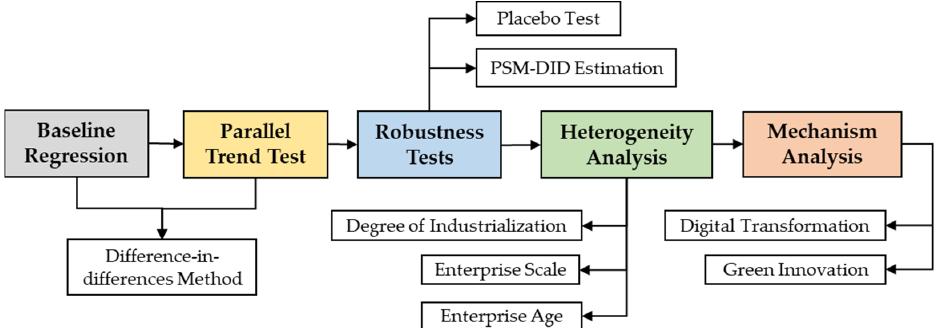
Figure 1. Research framework and processes .